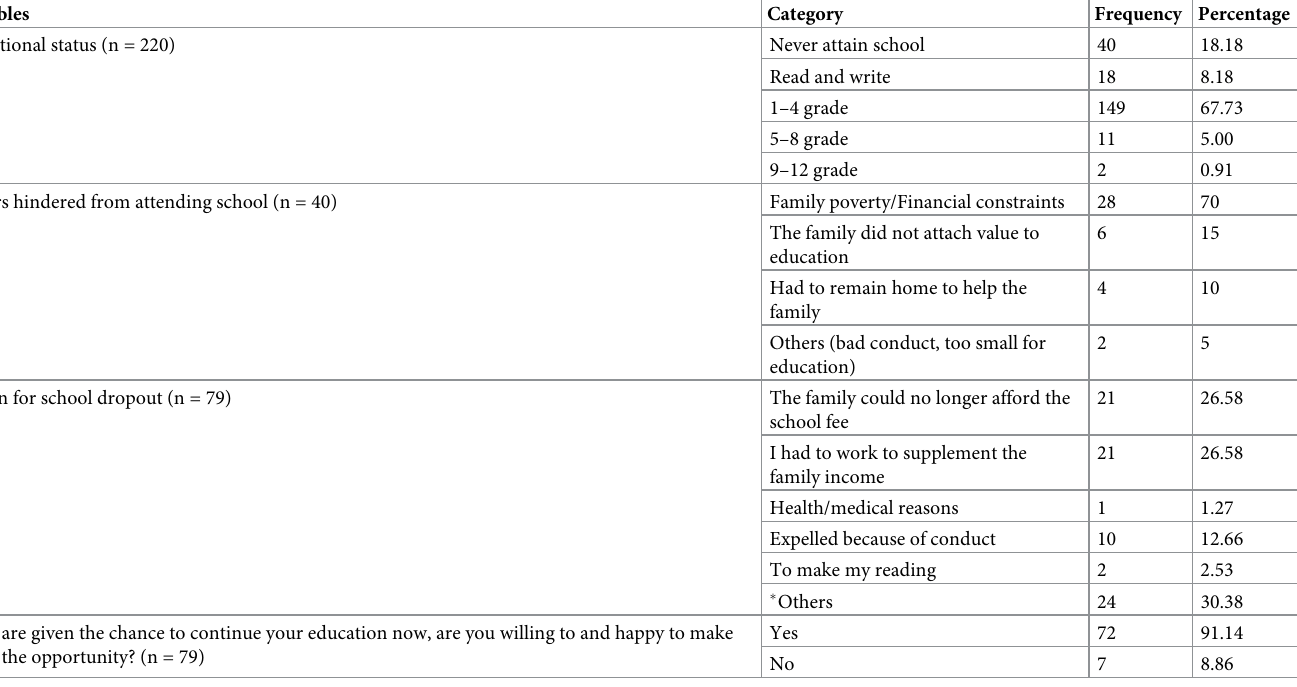
Table 2. Educational status of the study participants in Harar, Eastern Ethiopia,